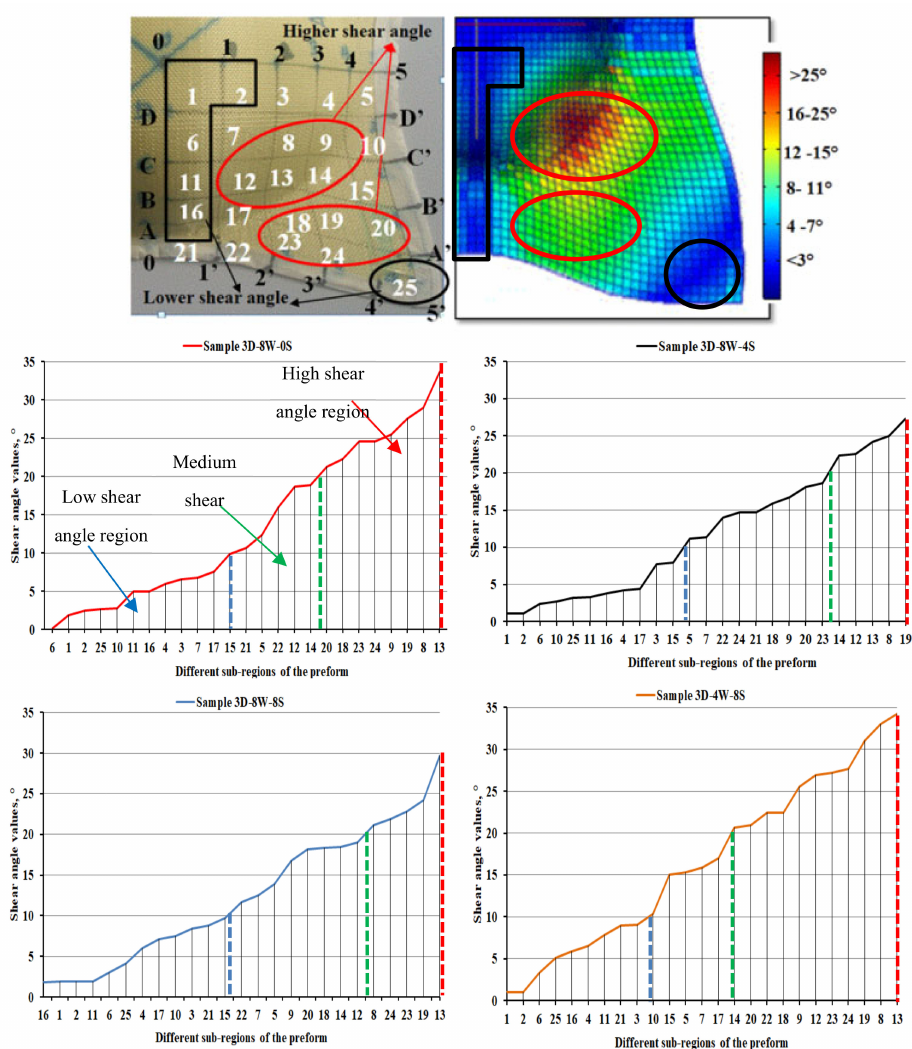
Figure 9. General in-plane shear angle diagram representations for the selected sub-regions and its measurement values for the di ff erent 3D warp interlock